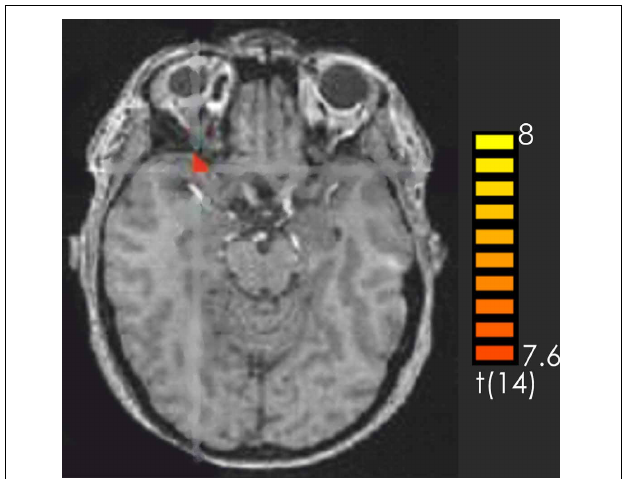
FIGURE 2 | Contrast of recognized > not recognized target pieces over all participants. The red-colored regions represent activation for the recognized target pieces. p < 0 . 001 (not corrected).